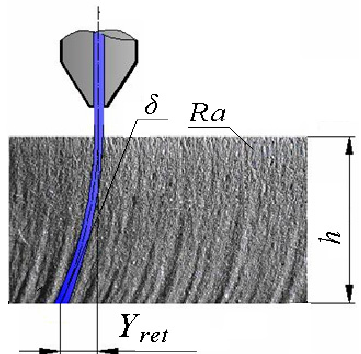
Figure 1. Geometrical parameters of the cut edge in the case of abrasive water jet cutting.